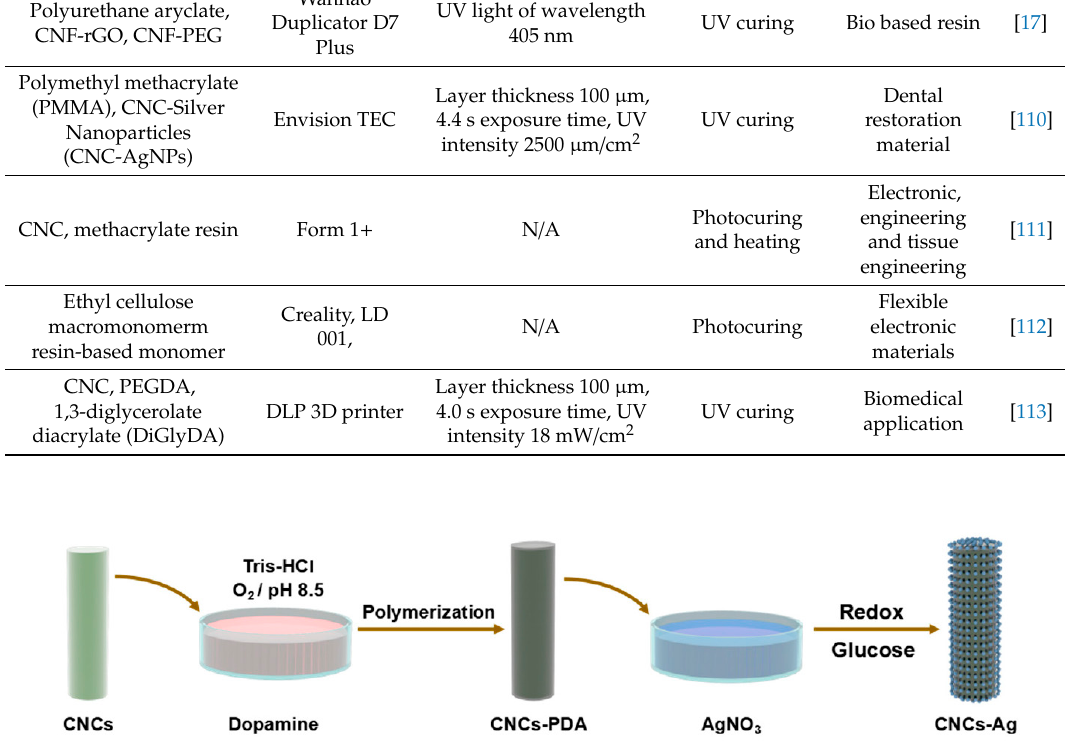
Figure 6. Synthetic route of nanocrystalline cellulose-silver (CNC-Ag) composite